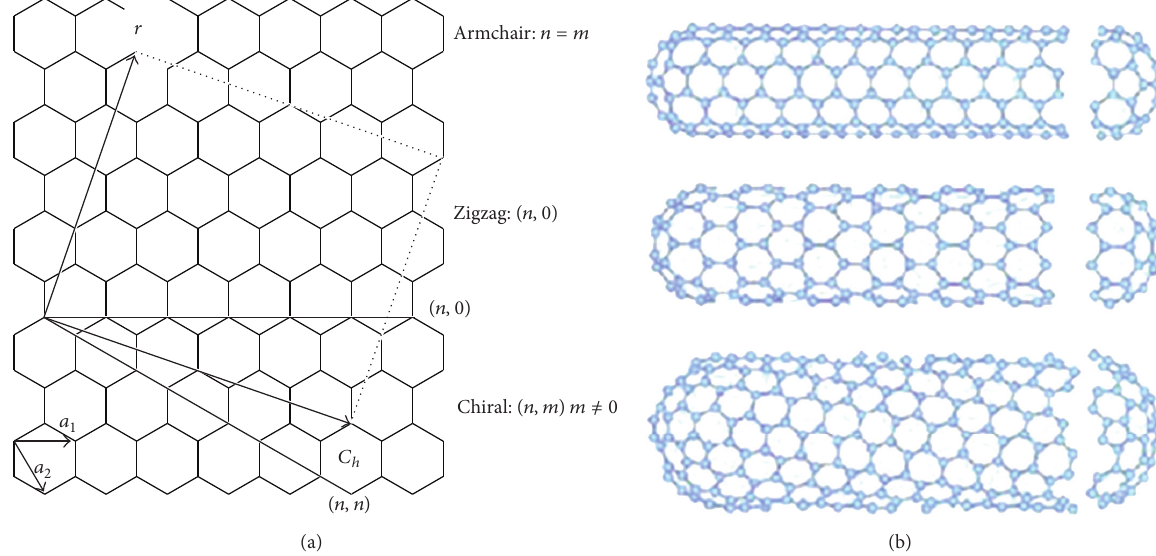
F 2: Schematic representation of (a) formation of single-walled carbon nanotubes by rolling of a graphene sheet along lattice vectors which leads to armchair, zigzag, and chiral tubes and (b) the three types of carbon nanotubes